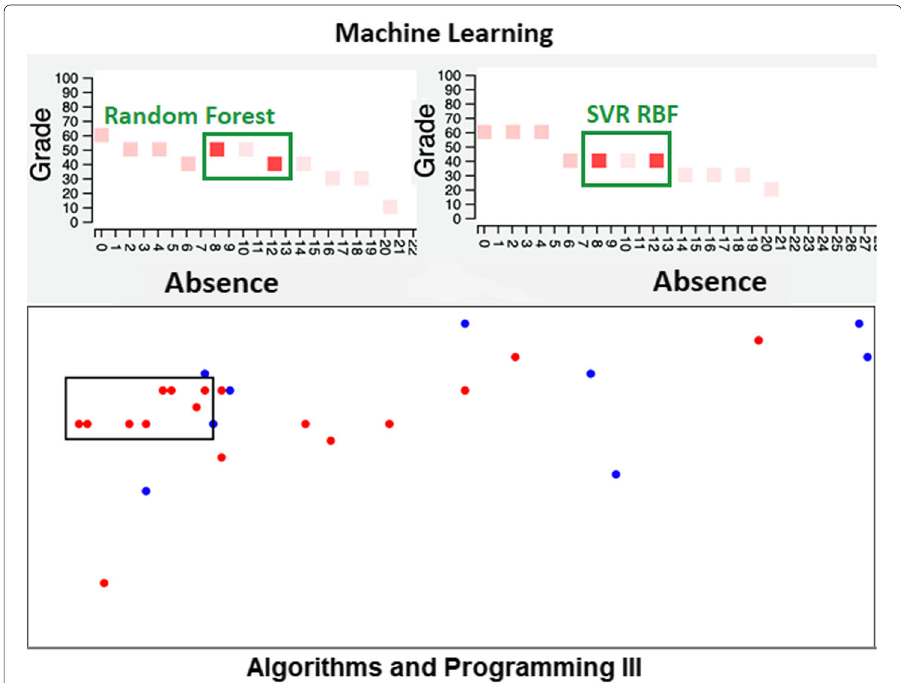
Fig. 17 Machine learning prediction and scatter plot for "Algorithms and Programming II". The scatter plot shows that a lower number of absences lead to better grades and this is predicted with high probability in both Random Forest and